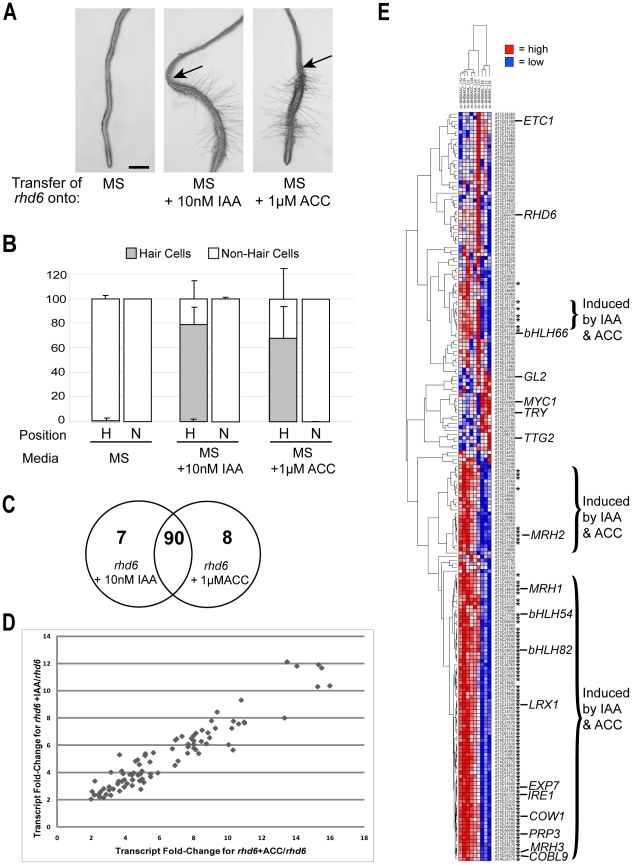
Molecular genetic analysis of root-hair differentiation induced by auxin and ethylene.(A) Roots of rhd6 seedlings grown for three days on unsupplemented (MS) media, and then transferred to either MS, MS+10 nM IAA, or MS+1 µM ACC and grown for two additional days. Arrows indicate the position of root tip at time of transfer. Scale bar: 200 µm (B) Quantitative analysis of root epidermal cell specification in rhd6 seedlings grown for three days on unsupplemented (MS) media, and then transferred to either MS, MS+10 nM IAA, or MS+1 µM ACC and grown for two additional days. The root-hair and non-hair cell types were determined from the portion of the root produced in the last two days. (C) Core root epidermal genes significantly affected (>2-fold change; <0.5% FDR) by transfer of rhd6 WER::GFP seedlings to either MS+10 nM IAA, or MS+1 µM ACC (relative to transfer to MS). After two days of seedling growth on the transferred media, root epidermal cells were collected by GFP-based cell sorting and the RNA used for ATH1 microarray analysis. (D) Plot of the fold-change for the 90 root epidermal genes induced by IAA and by ACC following transfer of rhd6 WER::GFP seedlings to either MS+10 nM IAA, or MS+1 µM ACC. (E) Hierarchical clustering of 208 core root epidermal genes based on their transcript levels on ATH1 chips (triplicate biological replicates) using RNA from developing root epidermal cells in rhd6 WER::GFP seedlings grown for three days on unsupplemented (MS) media, and then transferred to either MS, MS+10 nM IAA, or MS+1 µM ACC and grown for two additional days. Red = high transcript level; Blue = low transcript level. Asterisks indicate genes significantly affected by the hormone treatments.